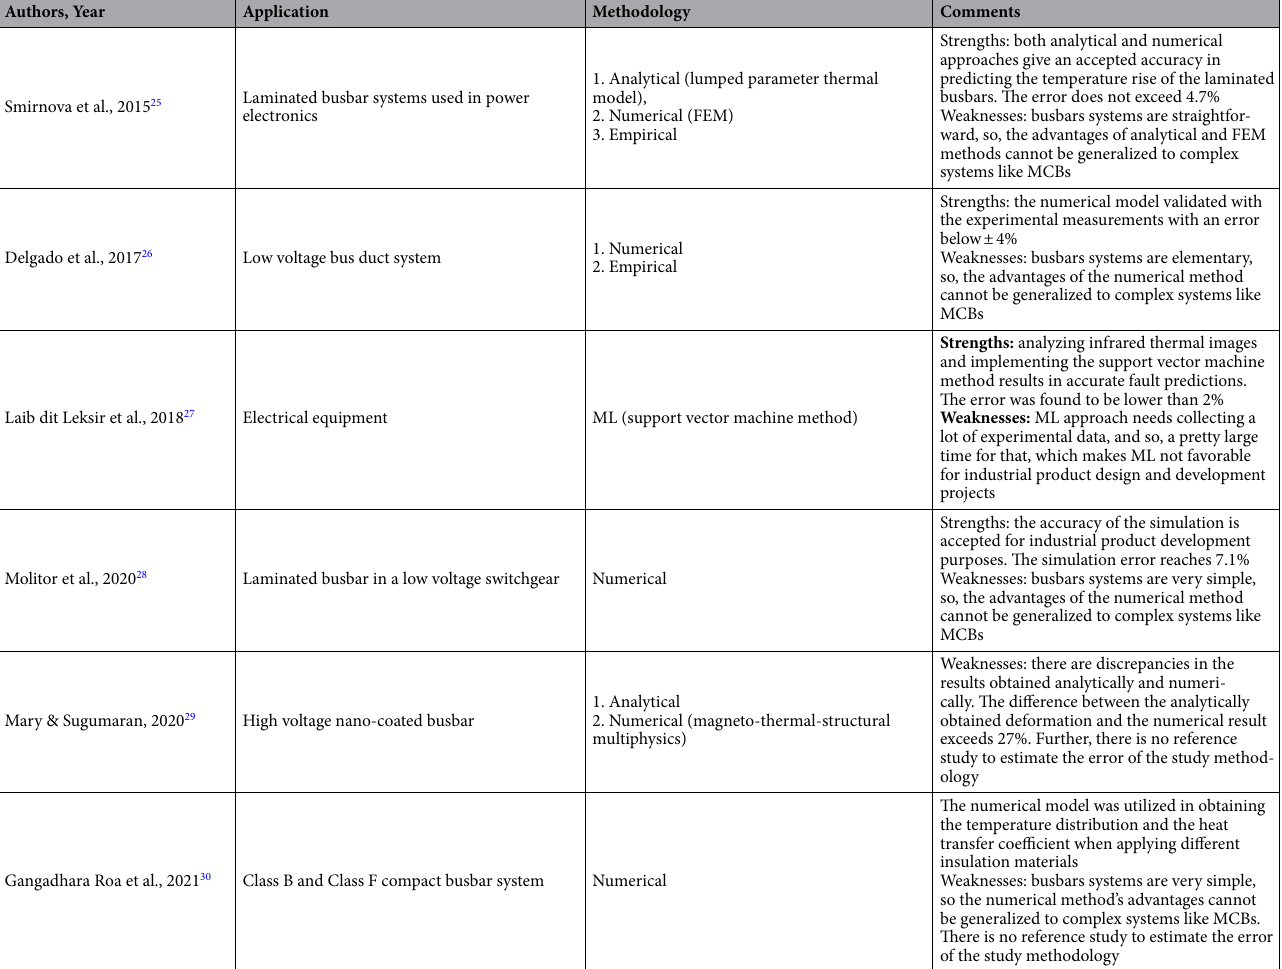
Table 1. Recent studies of electrical distribution